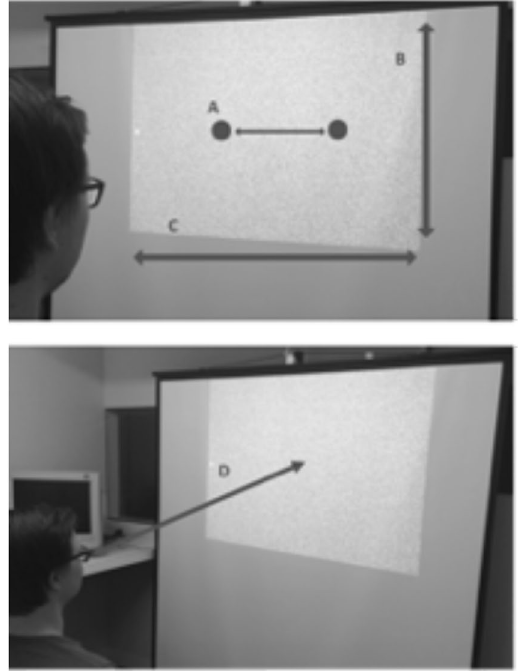
Figure 2. Graphics depicting the visual display for Experiment 1. ( A ) Position of speakers, mounted to the rear of the display, used to present audio stimuli, ( B ) Height of display area (86 cm), ( C ) Width of display area (112 cm) ( D ) Viewing distance (137